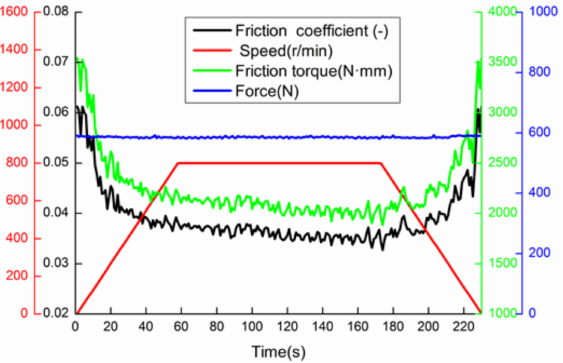
Figure 8. Measurement data from one test